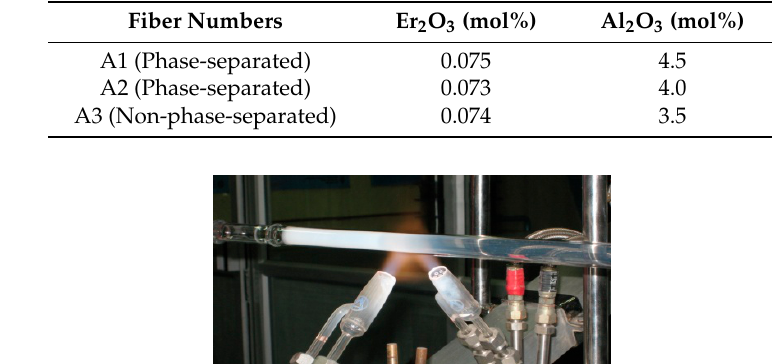
Table 1. The composition of three Er 2 O 3 -doped fiber preforms (Measured by electron probe microanalysis).